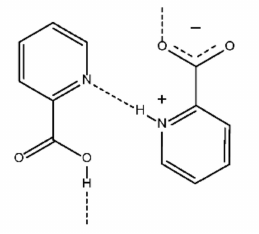
Figure 5. Schematic representation of the crystalline packing arrangement of 2-pyridinecarboxylic acid (adapted from ref.